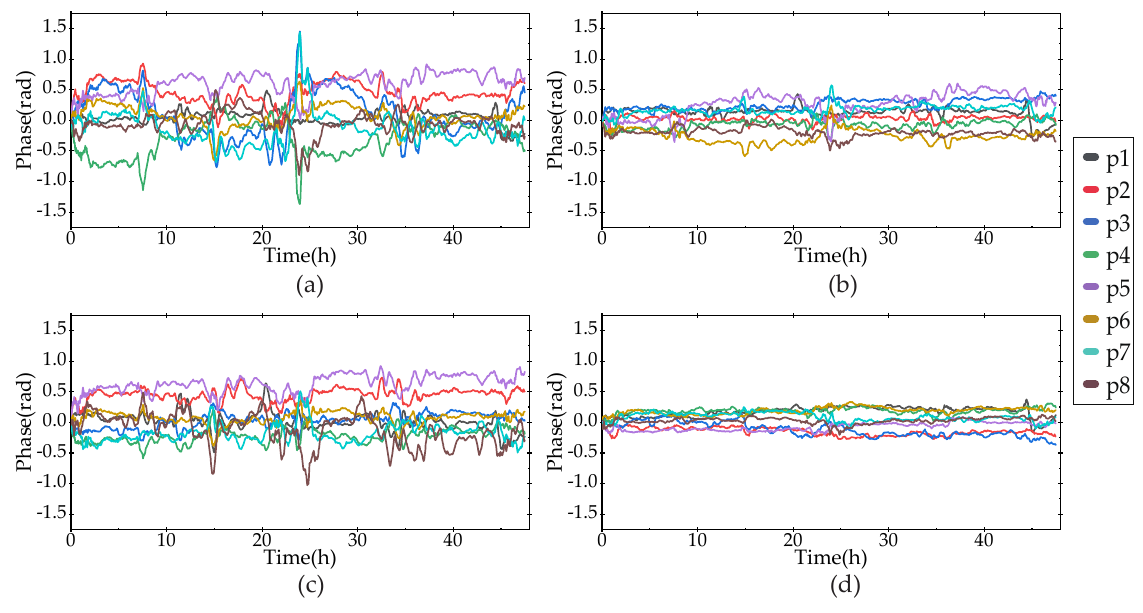
Figure 22. Corrected CP curves of RPSs p 1 – p 8 in Figure 2: ( a ) 2nd-order slant distance model, ( b ) 2nd- order slant distance model with azumithal partition, ( c ) slant distance & azimuth model, ( d ) the proposed method with overfitting correction.